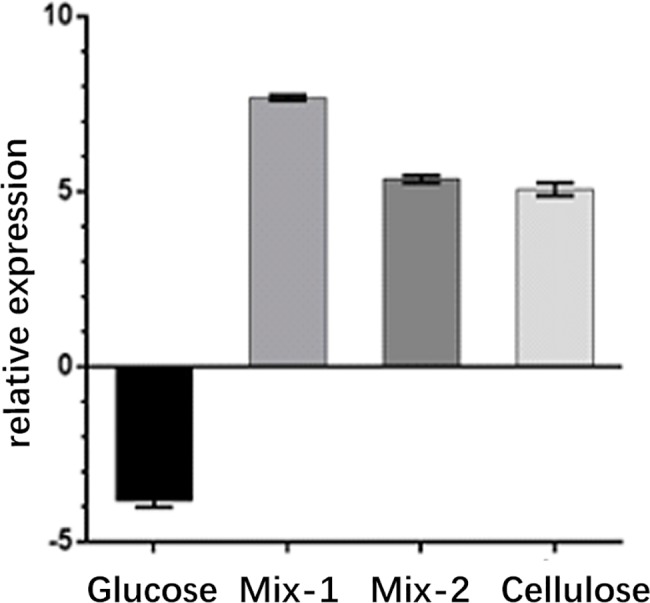
The relevant expression of surfactin of B. subtilis HH2 in four different media by RT-qPCR.